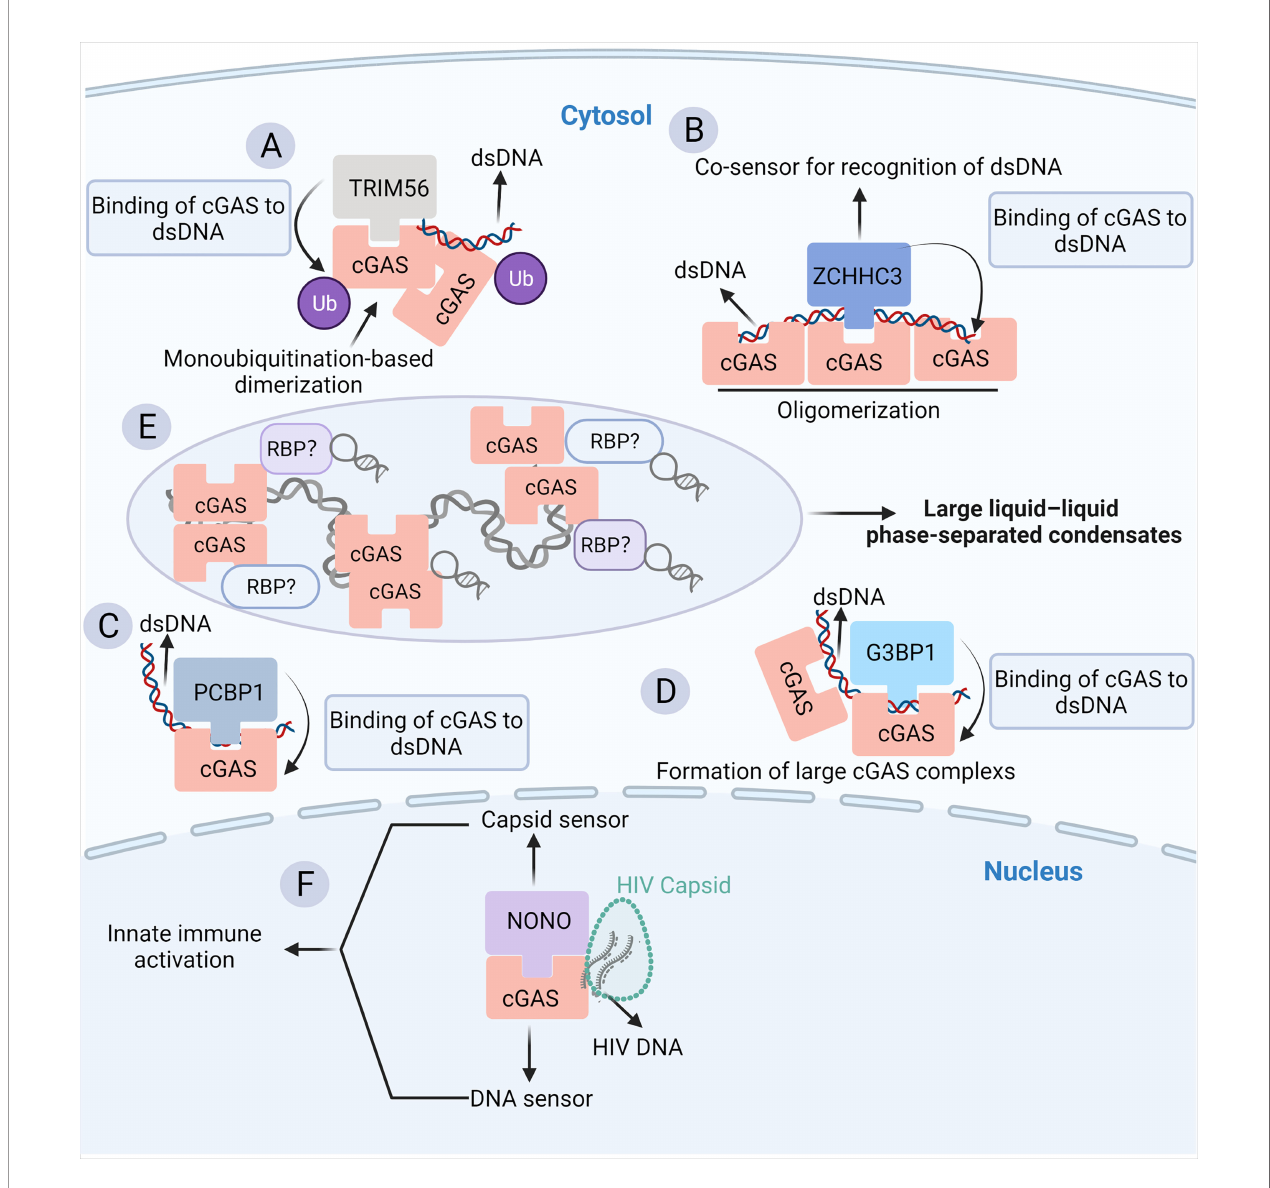
FIGURE 3 | The RBP partners of cGAS. (A) The binding of TRIM56 to cGAS induces the Lys335 monoubiquitylation of cGAS, thereby increasing the dimerization and DNA-binding activity of cGAS. (B) ZCCHC3 acts as a co-sensor for the recognition of dsDNA by cGAS. Brie fl y, ZCCHC3 binds to dsDNA and interacts with cGAS in the cytoplasm, enhancing the binding of cGAS to dsDNA and the formation of a large cGAS complex. (C) PCBP1 is a critical regulator of DNA recognition by cGAS. PCBP1 was recruited to cGAS in a viral infection-dependent manner. PCBP1 bound to DNA and enhanced cGAS binding to dsDNA. (D) G3BP1 physically interacts with and primes cGAS for ef fi cient activation. G3BP1 enhanced the DNA binding of cGAS by promoting the formation of large cGAS complexes. (E) The binding of cytosolic dsDNA to cGAS induces a robust phase transition to liquid-like droplets, which are considered as microreactors with concentrated RNA and RBPs, suggesting a potential link between cGAS and RBPs. (F) NONO is an essential sensor of the HIV capsid in the nucleus. NONO forms a complex with cGAS in the nucleus. Detection of the nuclear viral capsid by NONO promotes the recognition of DNA by